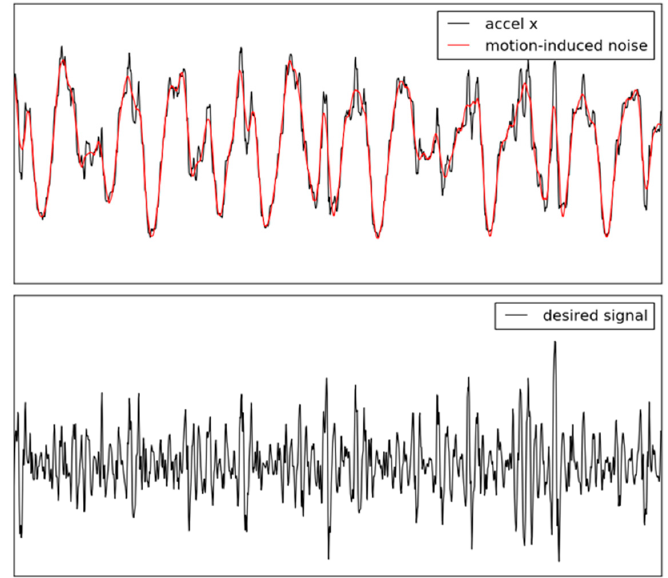
Figure 3. Motion artifacts reduction by the Savitzky–Golay filter.